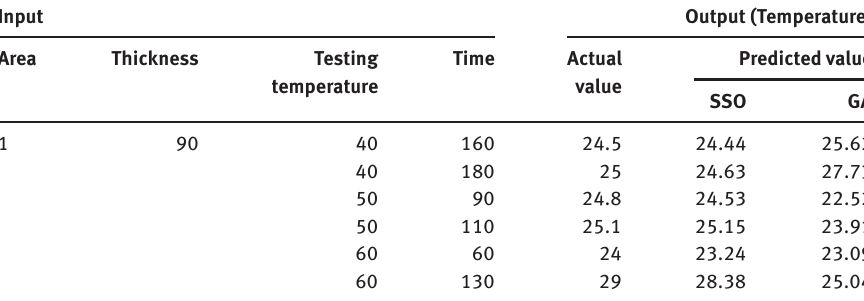
Table 3: Combined Ferro-Cement Wall and RCC Wall Panels.